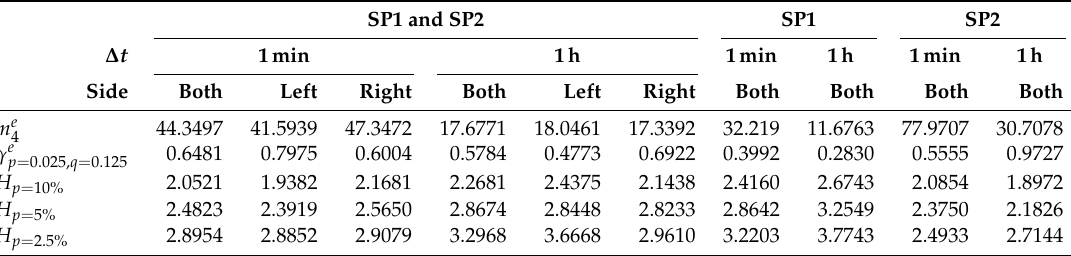
Table 7. Analysis of tails of the return distribution. This table shows measures for the tails of the distribution of logarithmic mid-price returns on different time scales ∆ t . We use kurtosis metrics based on the fourth standardized moment ( m e ) and based on quantiles ( γ e ), as well as tail indices p = 0.025, q = 0.125 4 from a Hill estimator ( H p ). The measures are applied to the full distribution as well as to the left and right side of the distribution only. SP1 and SP2 refer to subperiods of data. SP1 and SP2